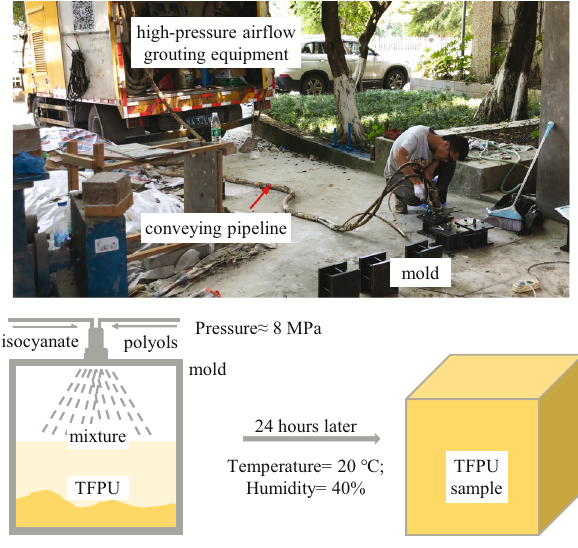
Figure 2: The preparation and curing processes of the TFPU